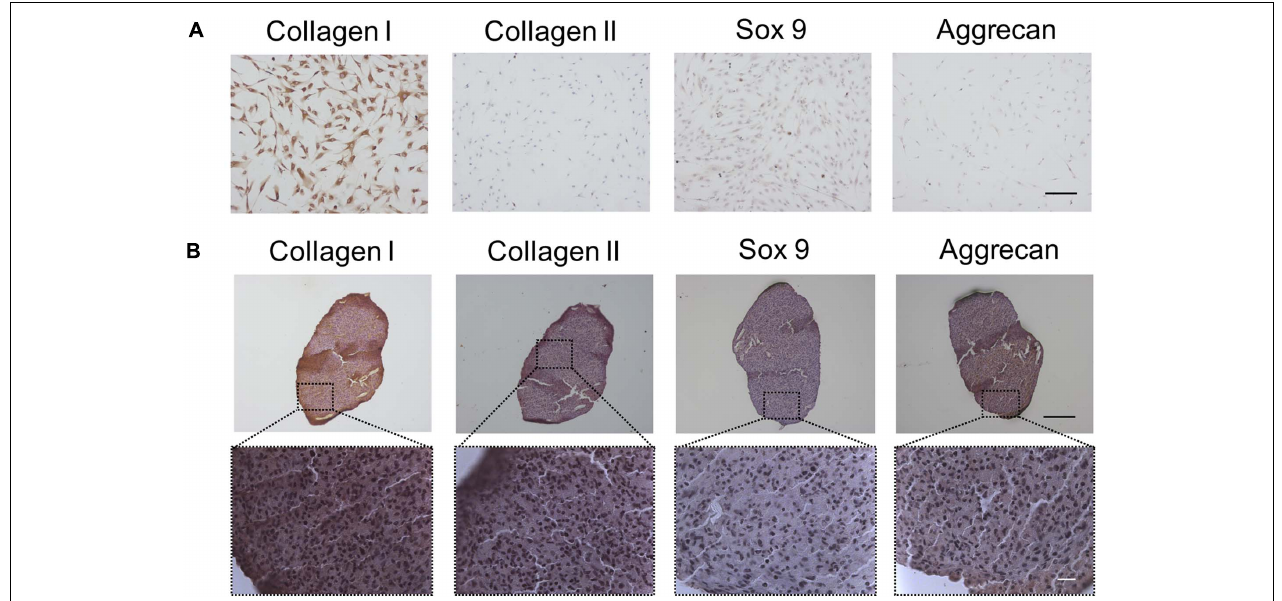
FIGURE 1 | The fibrochondrocytes-related proteins expression of TSPCs by ICC or IHC staining. (A) TSPCs were cultured in completed medium in monolayer for 24 h, scale bar 200 µ m. (B) TSPCs were induced in chondrogenic medium in pellet culture for 21 days, and continous slices were used to detect these proteins expression. Scale bar 100 µ m (top) and 20 µ m